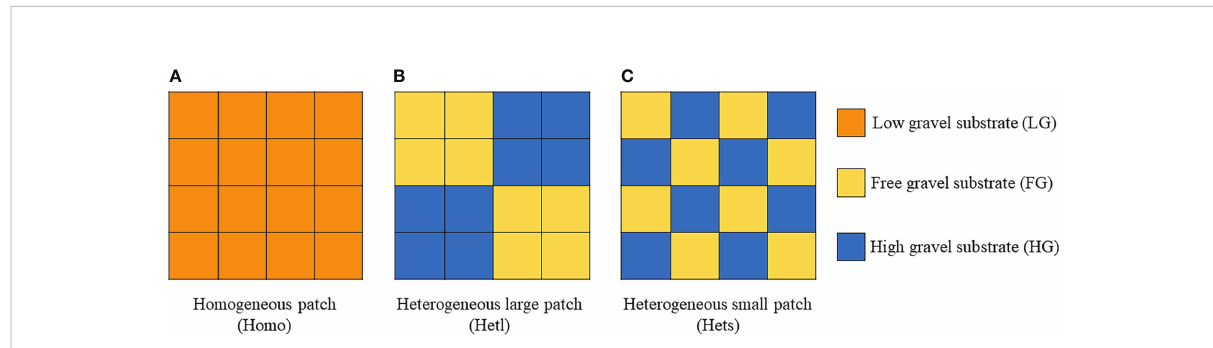
FIGURE 1 Schematic diagram of the experimental design. The experiment comprises three factors. The fi rst factor involved the AMF treatments, including inoculation with (M + ) or without (M - ) fungus. The second factor involved the substrate patchiness treatments, including the homogeneous patch (Homo) (A) , the heterogeneous large patch (Hetl) (B) and the heterogeneous small patch (Hets) (C) . The third factor involved the substrate gravel treatments, including the free gravel (FG) substrate, the low gravel (LG) substrate of 20% gravel, and the high gravel (HG) substrate of 40% gravel. In particular, the growth substrate remained uniform in mass and volume in any treatment except for patch